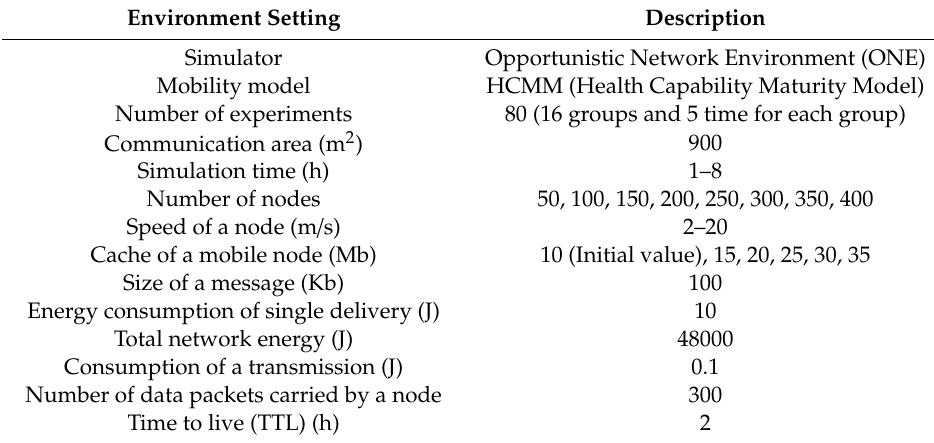
Table 3. The common experimental setup for simulation environment.